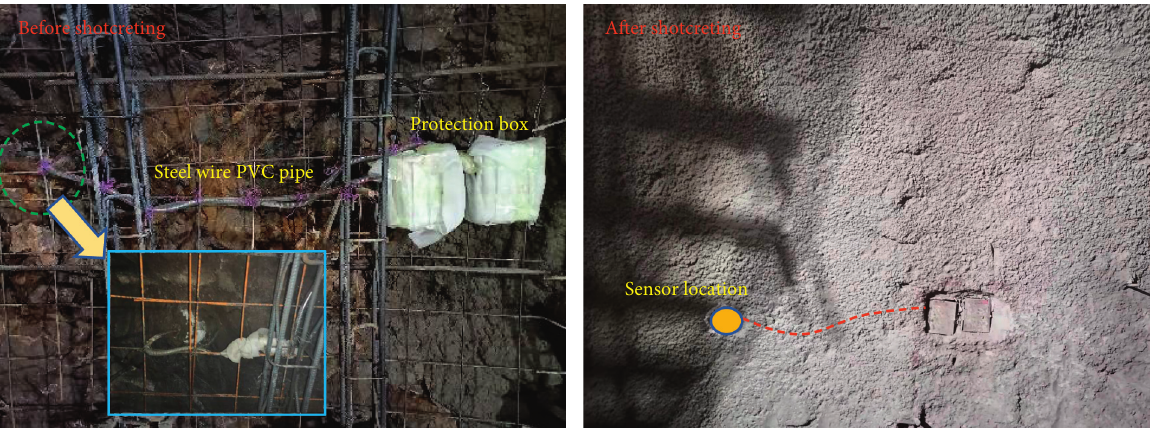
Figure 5: Site layout scheme of vibration measuring instrument.